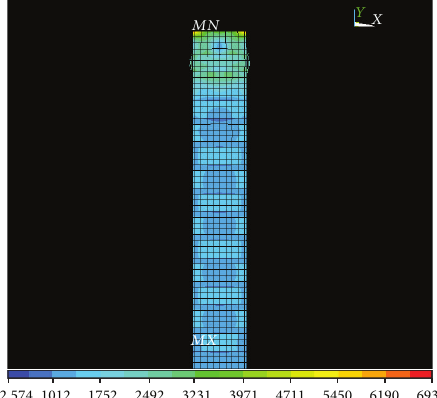
Figure 26: Typical computed deformed shapes of